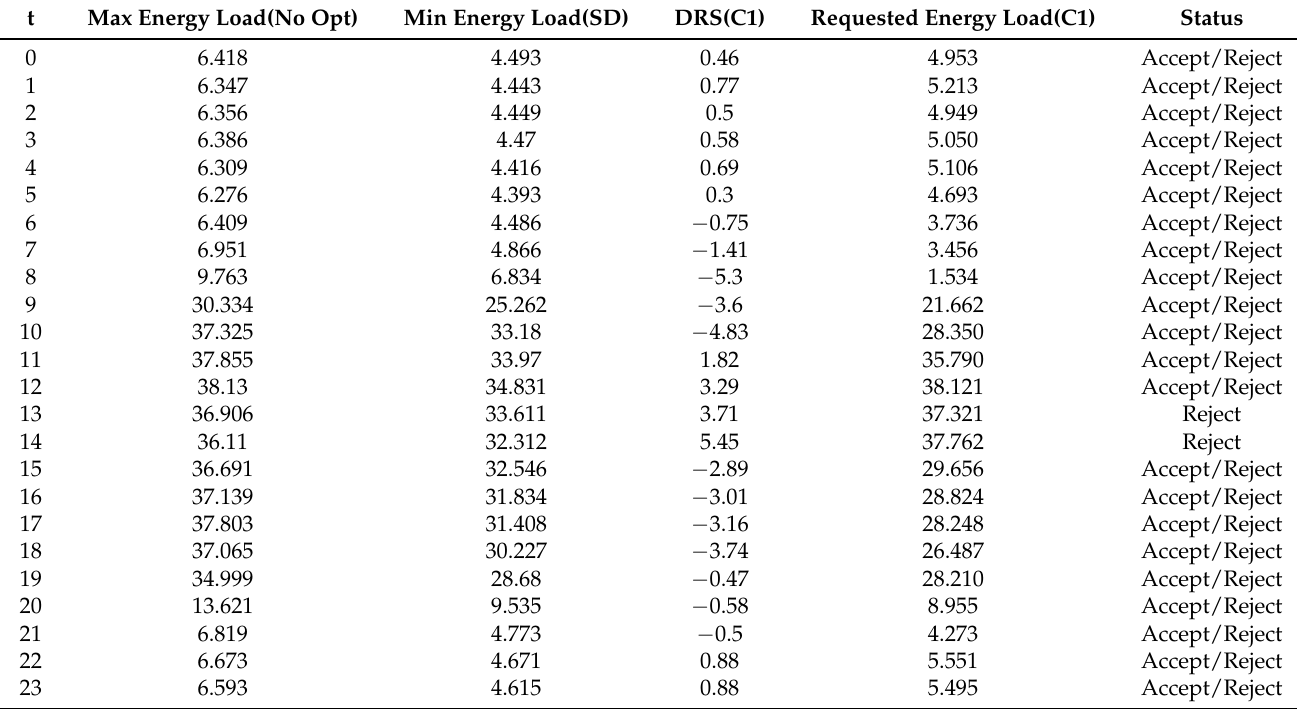
Table 4. Envisioned DR scheme and interaction between consumer and aggregator. Slight Discomfort (SD) for consumer.